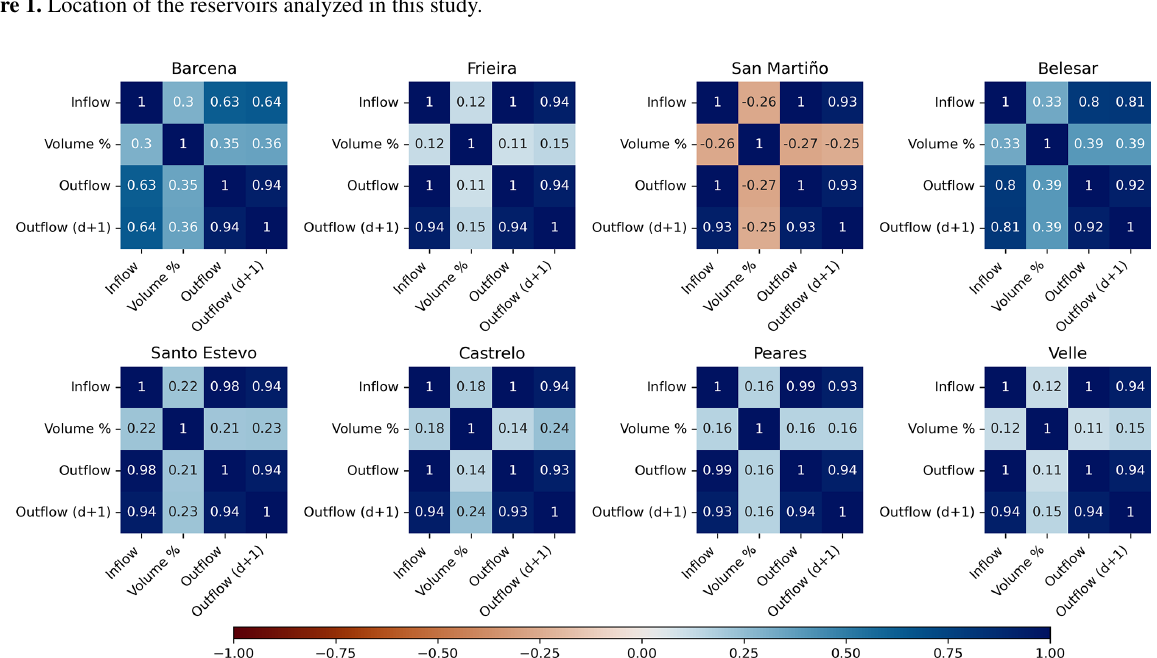
Figure 2. Correlation heatmaps for each of the analyzed reservoirs.